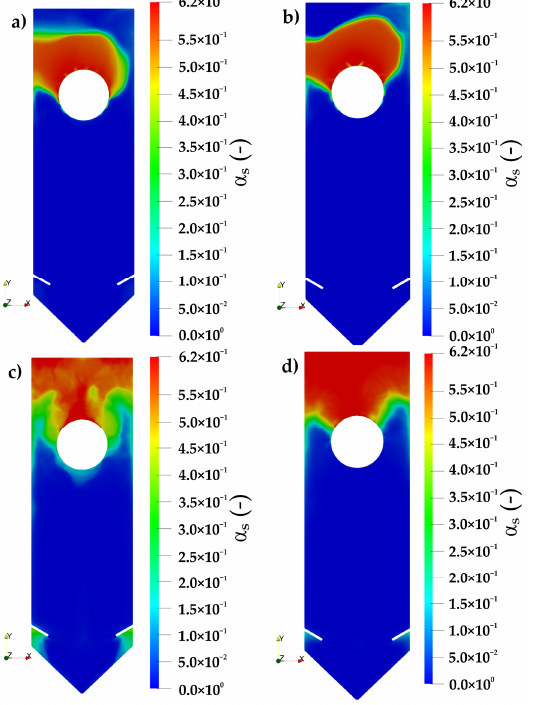
Figure 6. Time-averaged particle volume fraction distribution as a function of the solid holdup and the nozzle inlet pressure: ( a ) 400 g and 0.5 bar; ( b ) 400 g and 1 bar; ( c ) 700 g and 0.5 bar; ( d ) 700 g and 1 bar.